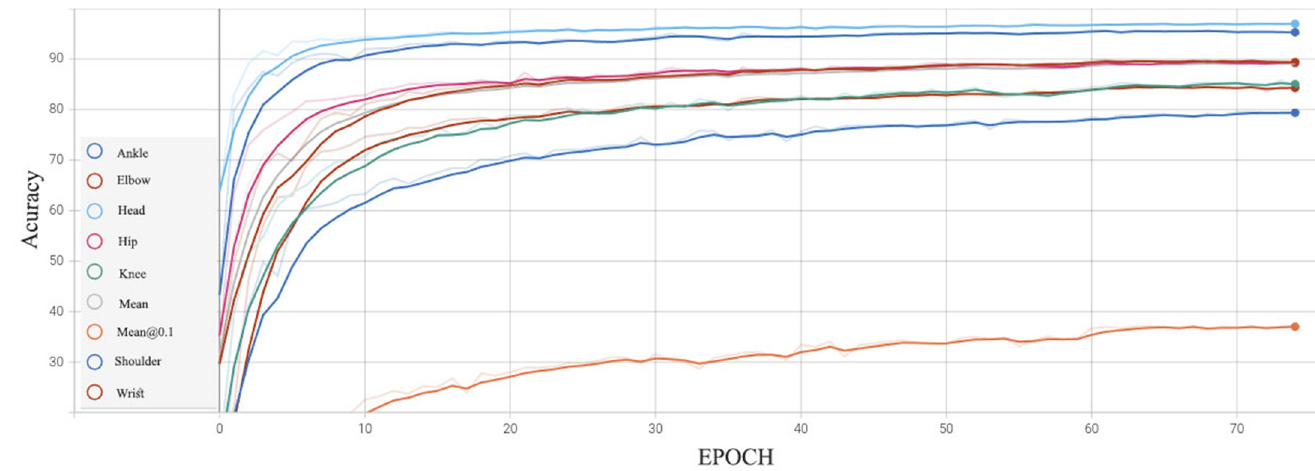
Figure 3. Visualization of Cofopose’s process of decoding for the keypoint detection transformer on MPII and COCO is denoted by the first and second rows, respectively. For MPII, the first, second, third, and fourth columns represent the right hip, left hip, left knee, and left ankle, respectively. For COCO, the first, second, third, and fourth columns represent right eye, right shoulder, right wrist, and right knee, respectively.